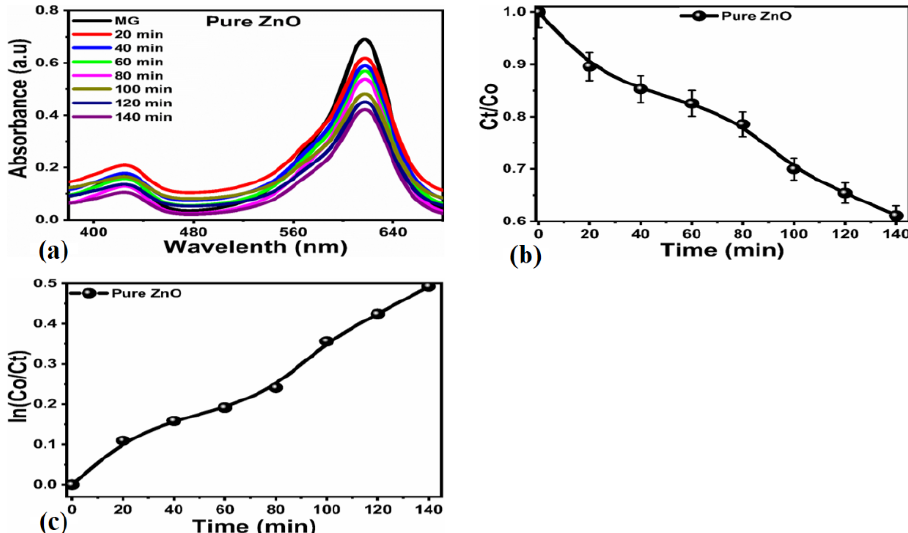
Figure 10. Degradation over time (140 min) of a solution of MG of concentration 5.48 × 10 −5 M under irradiation with UV light in the presence of 5 mg of pristine ZnO. ( a ) Time change of the UV-vis spectrum, ( b ) kinetics C t / C o irradiation time, ( c ) Ln C t / C o plot of pure ZnO over MG.